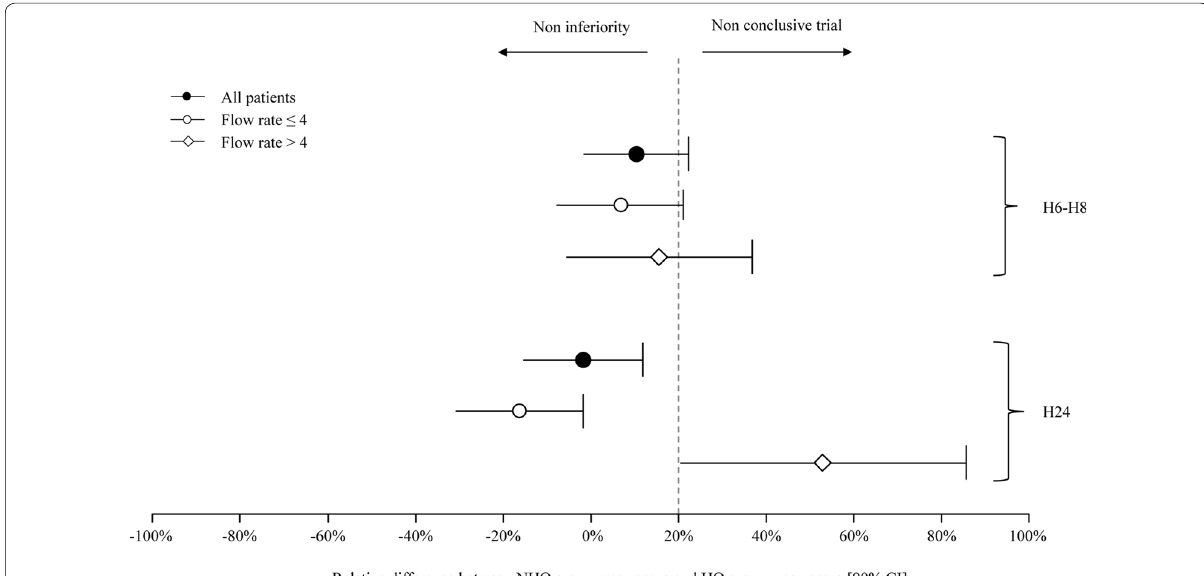
Fig. 4 Relative difference (with confidence interval) between non-humidified oxygen (NHO) group mean score and humidified oxygen (HO) group mean score at H6–H8 and